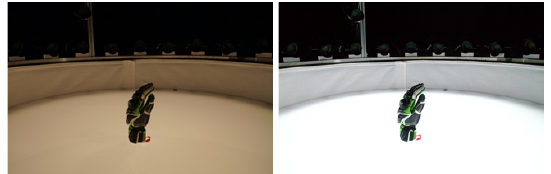
Figure 5: Example of the radiometric calibration result (right) on a raw image (left) of a glove.